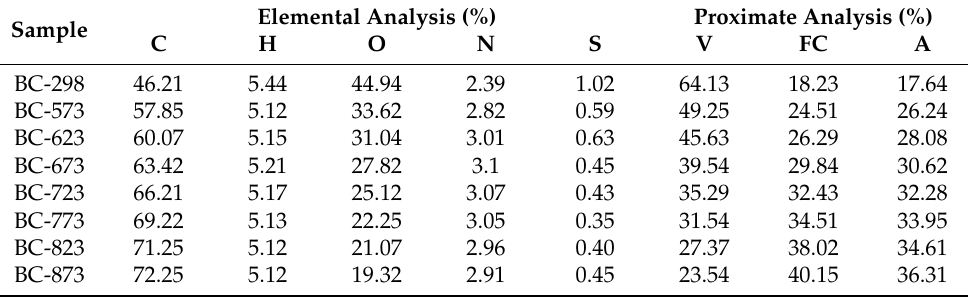
Table 1. Elemental and industrial analysis results of semi-coked cow